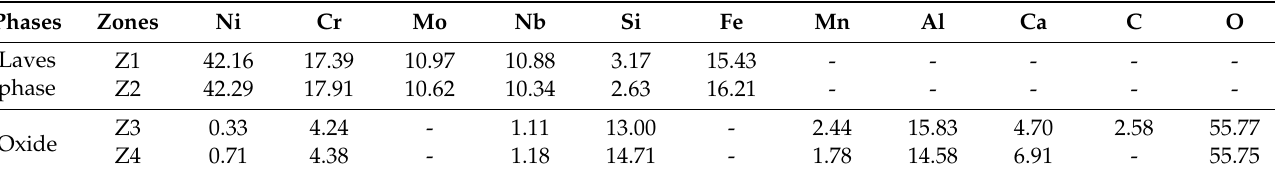
Figure 8. SEM image and the elemental maps obtained by EDX microanalysis showing segregation zones associated with the Laves phase and complex oxides. Table 4. Chemical composition (%) of the zones indicated in Figure 8.